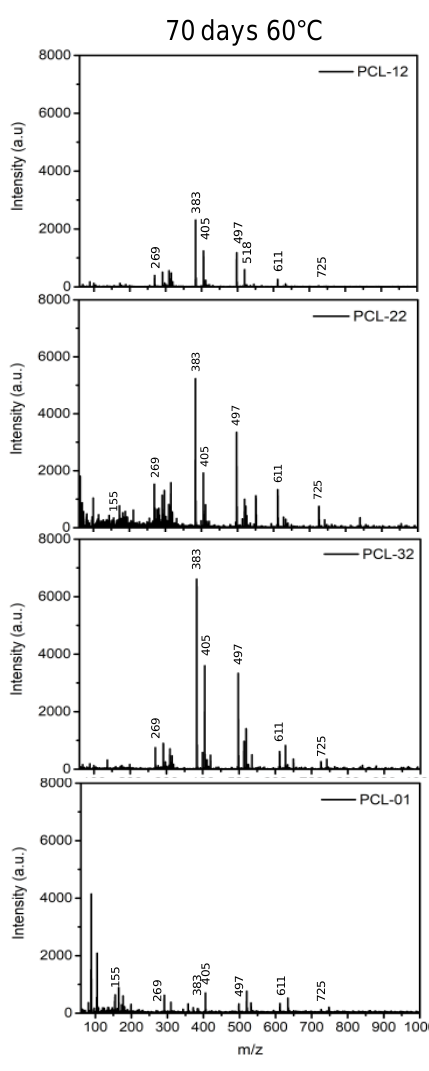
Figure 2. LDI-MS spectra of PCL-12, PCL-22, PCL-32 and PCL-01 after hydrolytic degradation for 70 days at 60 °C. The m/z values for the most abundant peaks are shown. Table 3. Peaks assignments with m / z of linear water-soluble degradation products observed by laser desorption ionization-mass spectrometry